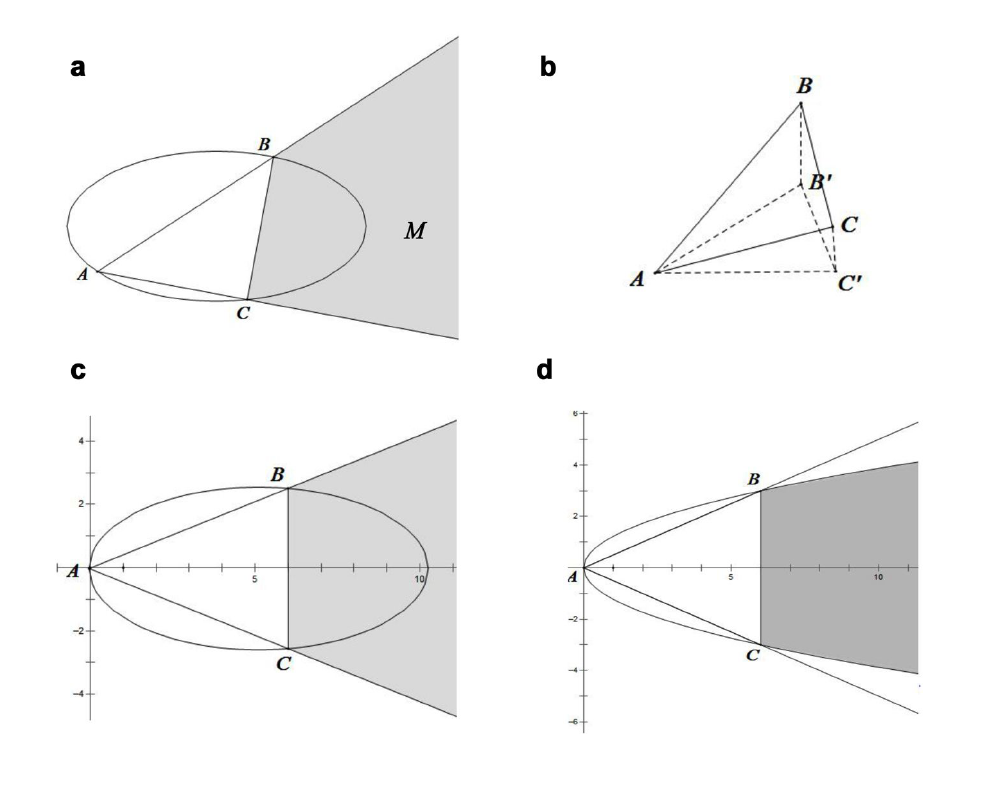
Figure 1: Proof of the existence of circumscribed ellipses of convex quadrilaterals. (a) Area M of a scalene triangle. (b) Proof of Lemma 1. (c) A rectangular coordinate system set up for an isosceles triangle. (d) The circumscribed ellipses of whose one of the main diameters is coincide with x-axis can cover the shaded